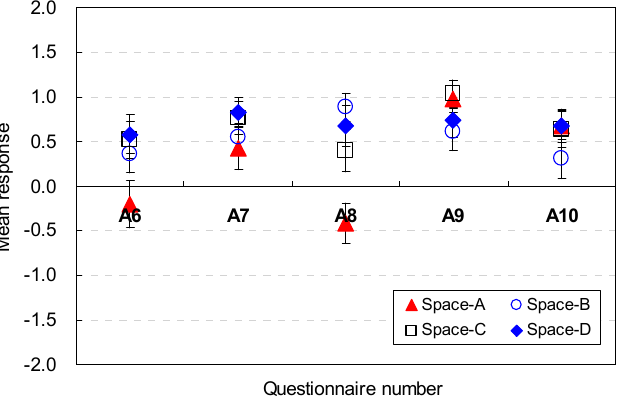
Figure 7. Spatial perception of the spatial shape in terms of amenity under height changes.